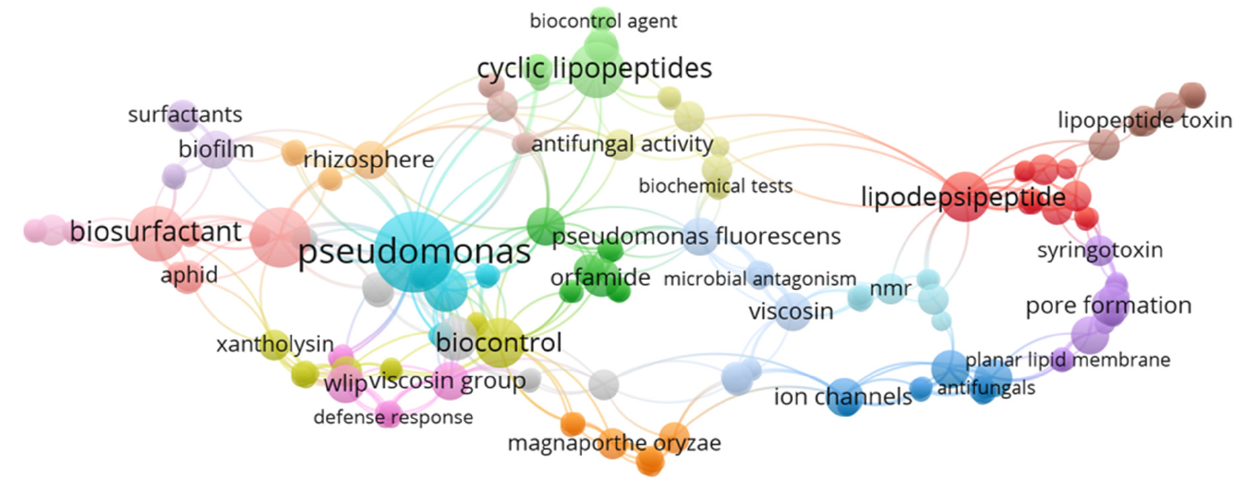
Figure 2. Bibliometric analysis for 118 papers published on cyclic lipopeptides of Pseudomonas according to the Scopus database using specific keywords such as viscosin OR amphisin OR bananamide OR cocoyamide OR orfamide OR tolaasin OR syringomycin OR syringopeptin OR xantholysin OR putisolvin OR entolysin AND Pseudomonas OR “cyclic lipopeptide” OR “cyclic lipopeptides” OR “CLPs” OR “lipopeptides” OR “lipopeptide” OR “LPs”.